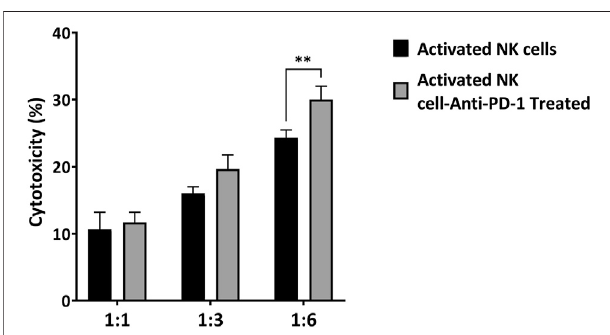
FIGURE 3 | Cytotoxicity of ex vivo activated NK cells and anti-PD1 antibody-treated NK cells toward MKN-45 cell at different E: T ratios. Data presented as means ± standard error (M ± SE) for three independent experiments. Statistical signi fi cance was determined using one-way ANOVA with * p <